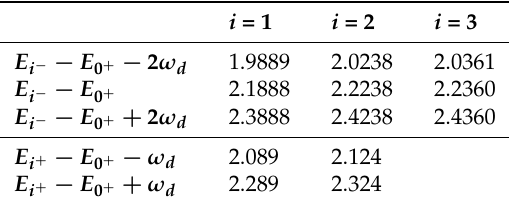
Figure 4. Difference ∆